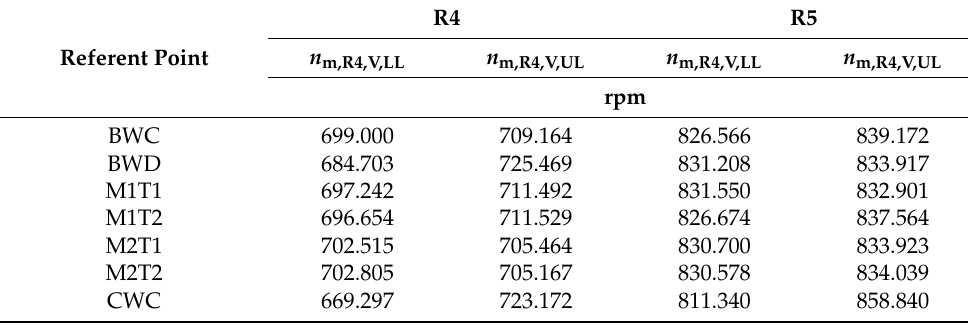
Table 7. Boundaries of the FREM resonant domains according to a V,per –EHO: 2.